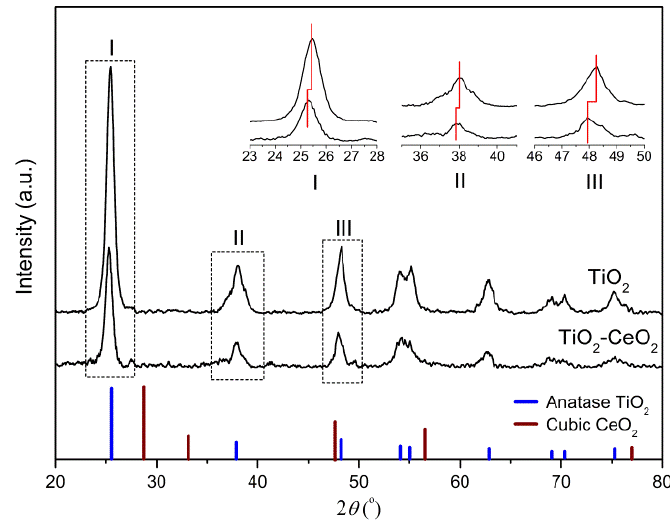
Figure 3. XRD patterns of the TiO 2 and TiO 2 -CeO 2 catalysts.